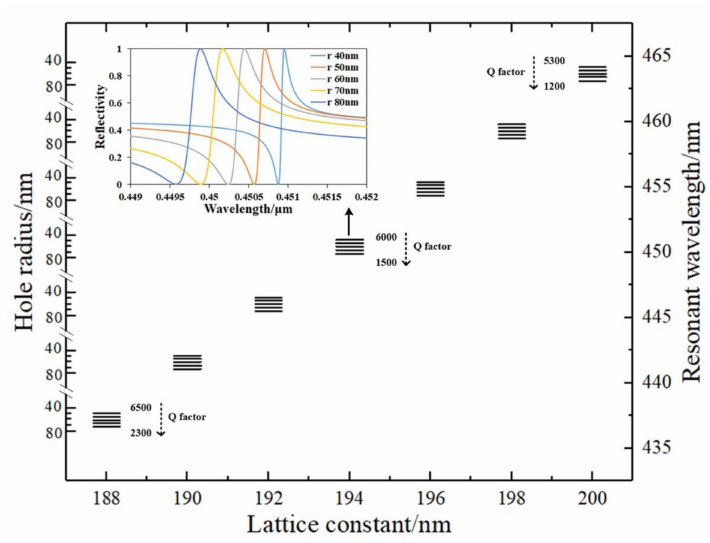
Figure 3. Influence of lattice constant and hole radius on resonant wavelength and mode Q